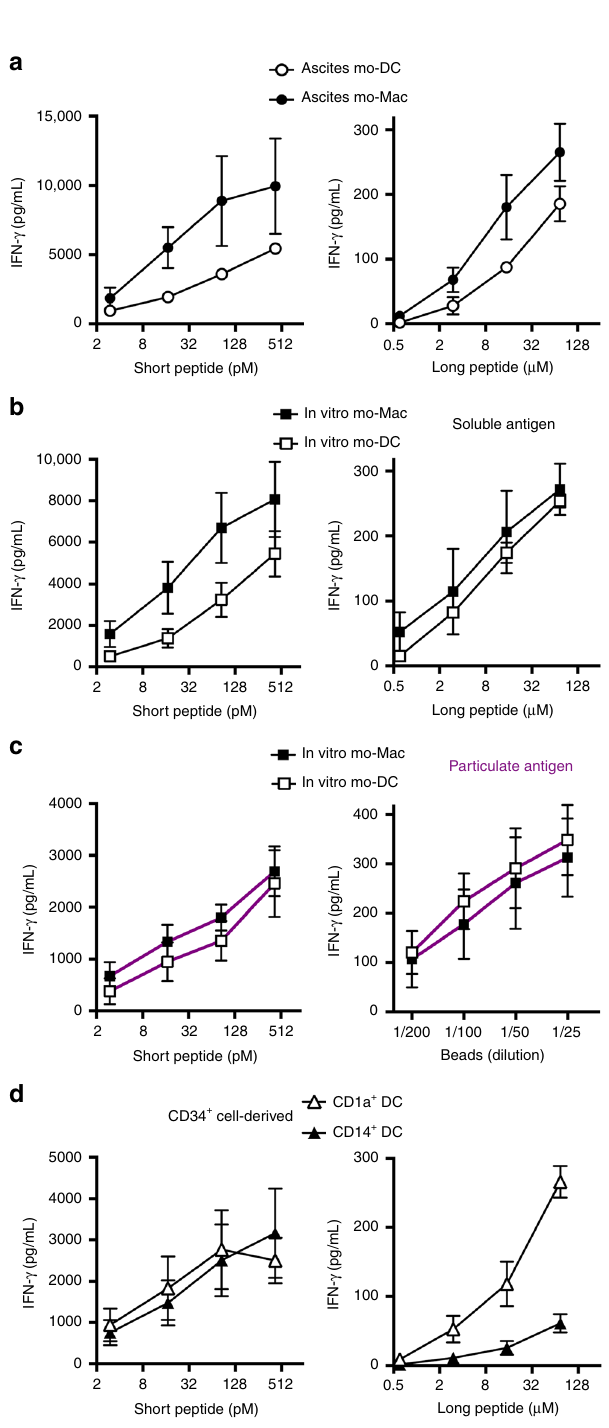
Fig. 3 Human mo-DCs and mo-Mac both cross-present ef fi ciently. Puri fi ed DCs and macrophages from tumor ascites ( a ) or in vitro culture of monocytes ( b , c ), or DCs derived in vitro from CD34 + precursors ( d ) were incubated with serial concentrations of MelanA long or short peptide ( a , b , d ) or MelanA-coated beads ( c ). After washing, antigen-speci fi c CD8 + T cells were added. After 24 h, IFN- γ secretion was assessed as a measure of T cell activation. Background level was subtracted. Mean ± SEM of three ( a , d ), six ( b ), or fi ve ( c ) independent